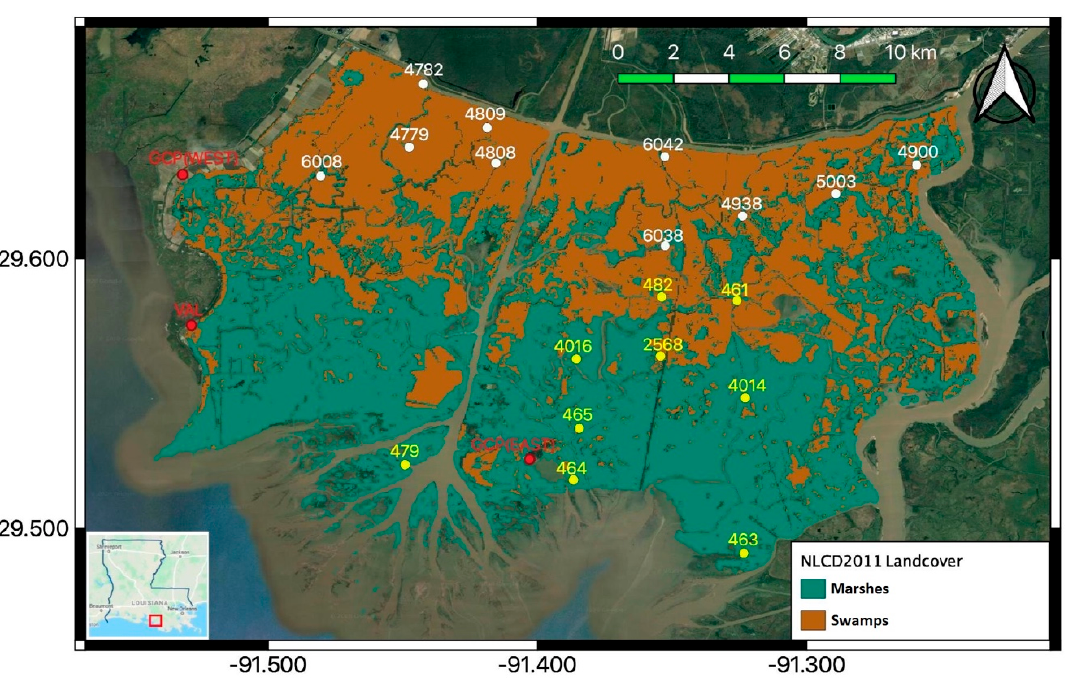
Figure 1. Land cover from the National Land Cover Database (NLCD2011) showing emergent herbaceous (marshes) and woody (swamps) wetlands within the study area, located within the Atchafalaya basin of coastal Louisiana, USA. The location of the Coastwide Reference Monitoring System (CRMS) stations are shown as white and yellow dots (white dots: swamp, yellow dots: fresh marsh). Red dots show the locations of the ground control points (GCPs) and validation point (VAL). The inset at bottom left shows the location of the study area in Louisiana. (Background Map from Google [26]).